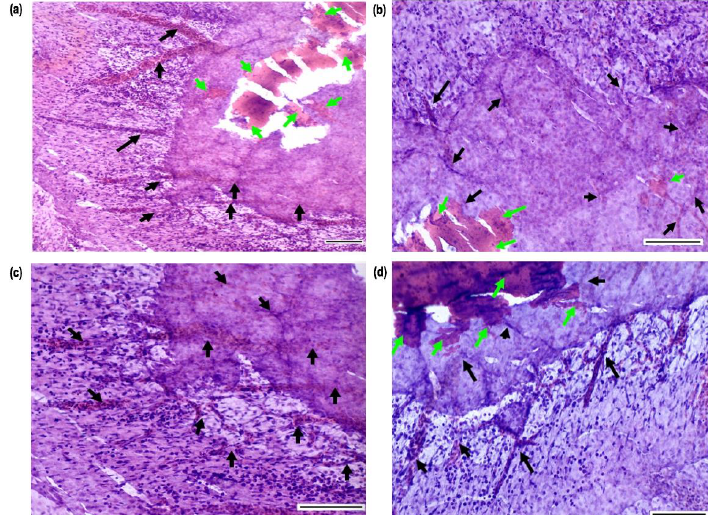
Figure 13. Histology images of CAM tissue-hydrogel slides obtained after horizontal sectioning and H&E staining: Images represents the connective tissue surrounding hydrogels with tiny blood vessels grooving into them (Images were taken at a magnification of ( a ) × 10 and ( b – d ) at × 20, and all scale bars equal to 10 µ m. The green and black arrows represent hydrogels, and blood vessels,